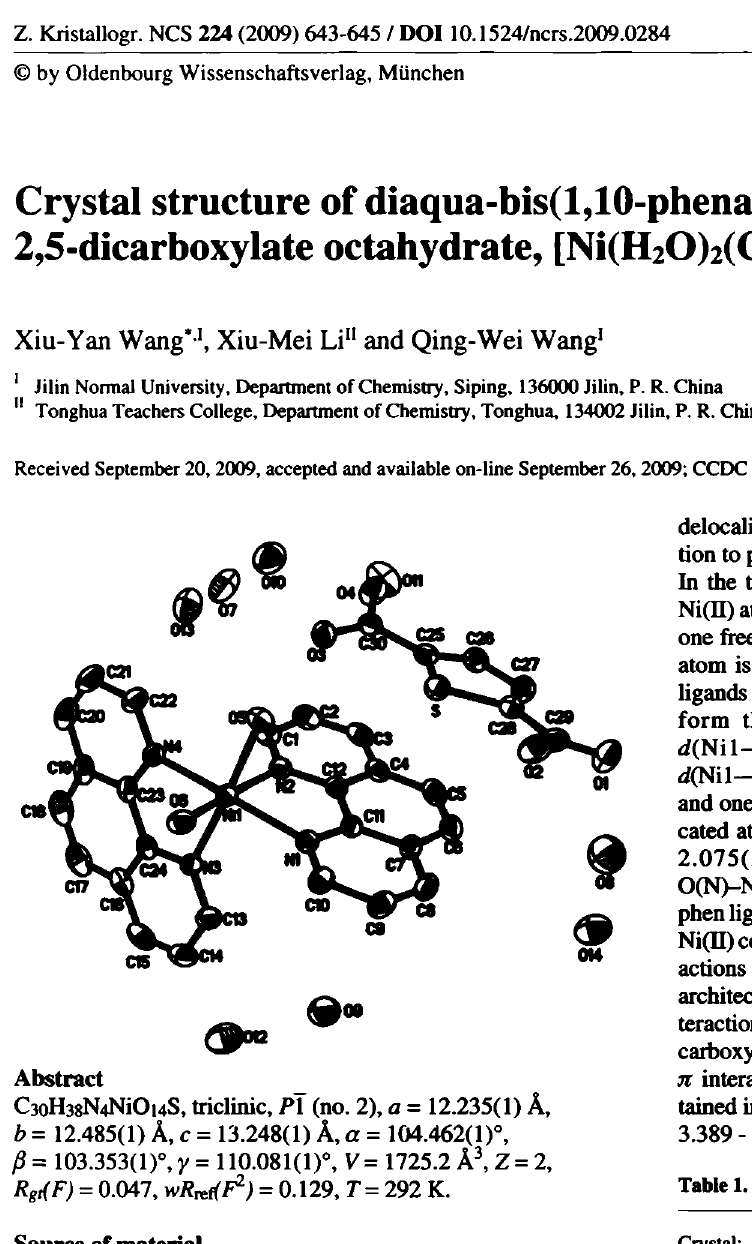
Table 1. Data collection and handling.